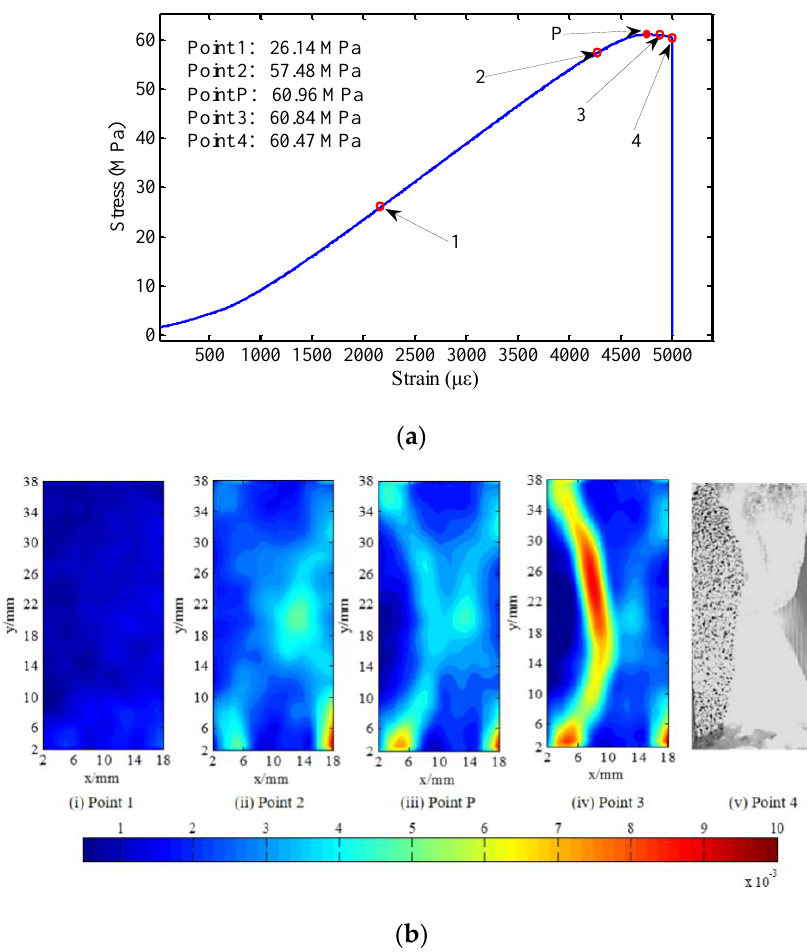
Figure 2. Response of rock specimen under uniaxial compression: ( a ) Stress–strain curve; ( b ) maximum shear strain fields under different stress levels and failure forms of the rock specimen.